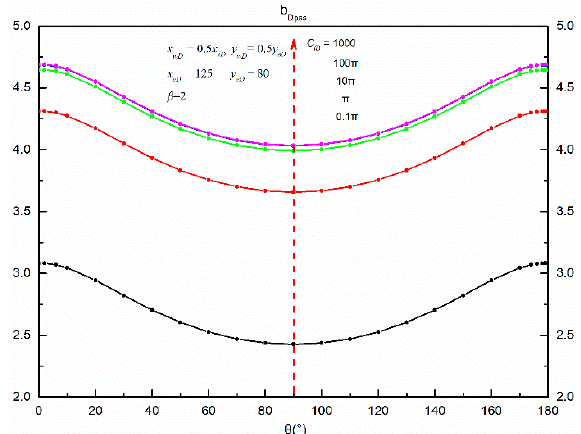
Figure 7. Effect of fracture conductivity on pseudo-steady-state constant.